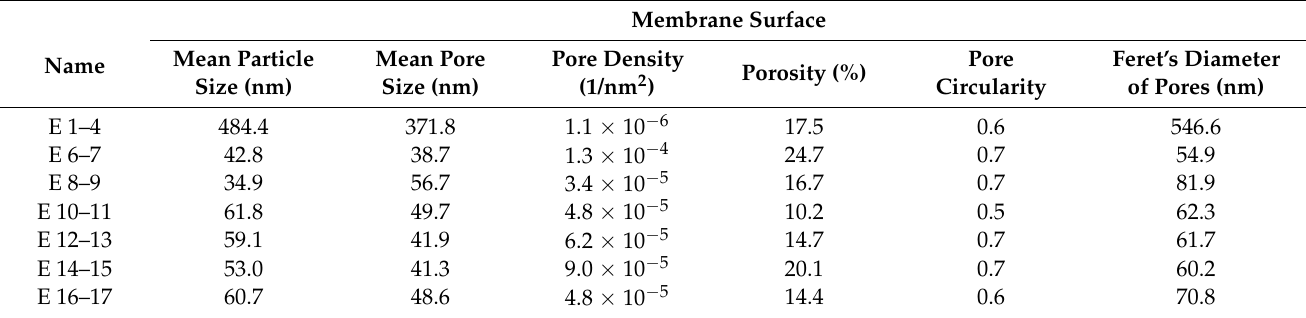
Table 6. ImageJ analysis of SEM images of the surface of the